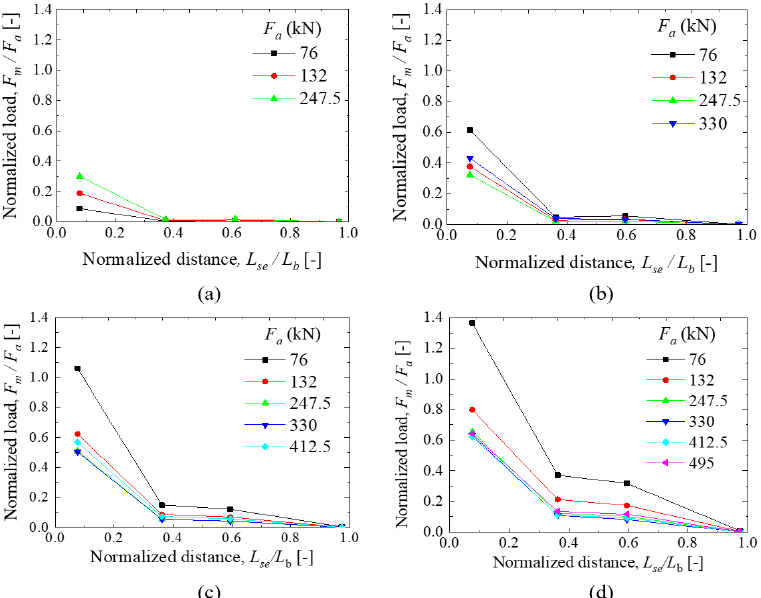
Figure 13 - Load distribution on bonded length of anchor T33 during the suitability test: (a) 1st loading stage; (b) 2nd loading stage; (c) 3rd loading stage; (d) 4th loading stage.